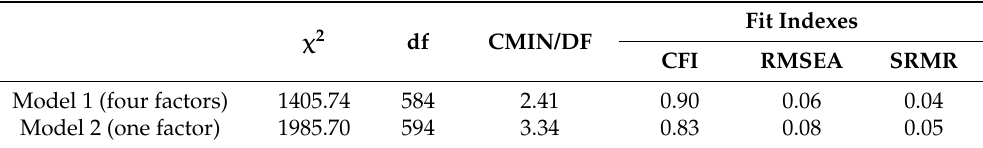
Table 3. Goodness of fit statistics ( N = 353).